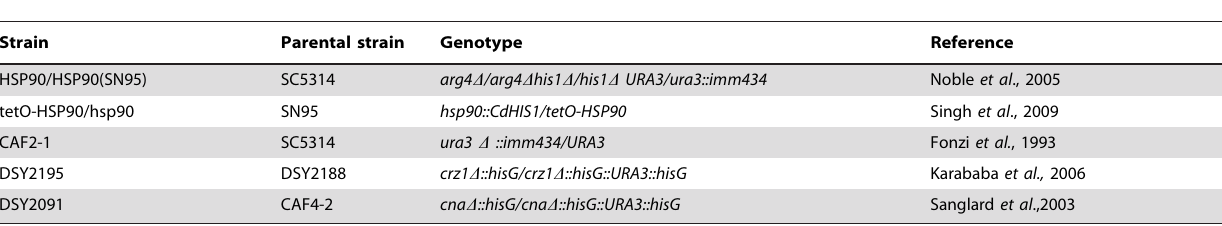
Table 7. C. albicans strains used in this